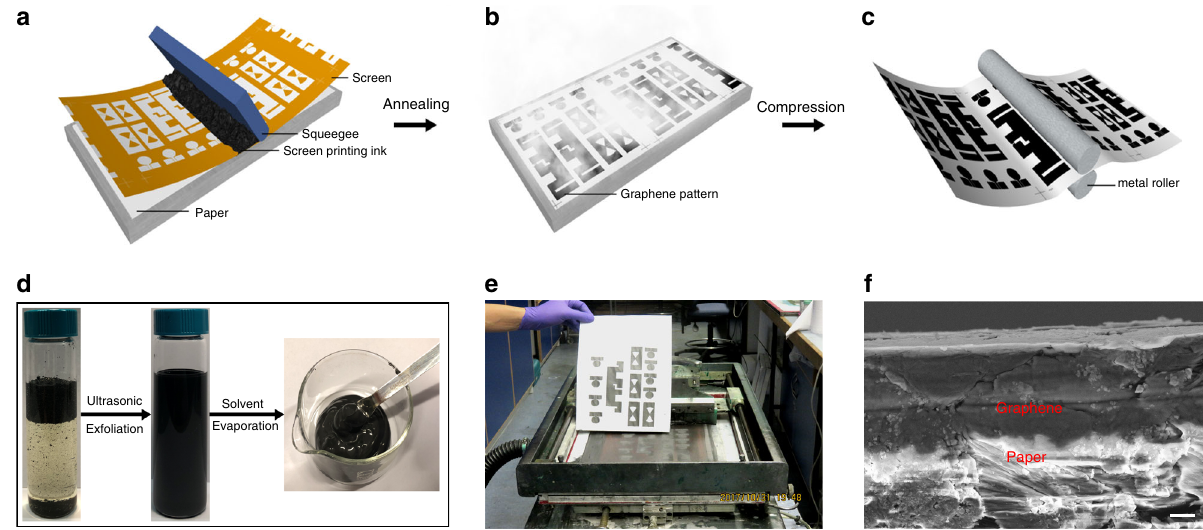
Fig. 3 Graphene antenna fabrication using screen printing technology. Screen-printing steps: a Patterning graphene ink via exposed screen and squeegee, b annealing printed patterns and c compressing dried pattern with steel rolling machine. d Cyrene-based graphene ink and high concentrated (70 mg mL − 1 ) screen printing ink. e Demonstration of printed antennas on A4 paper. f SEM cross-sectional view of the printed graphene antenna; scale bar is 1 µ